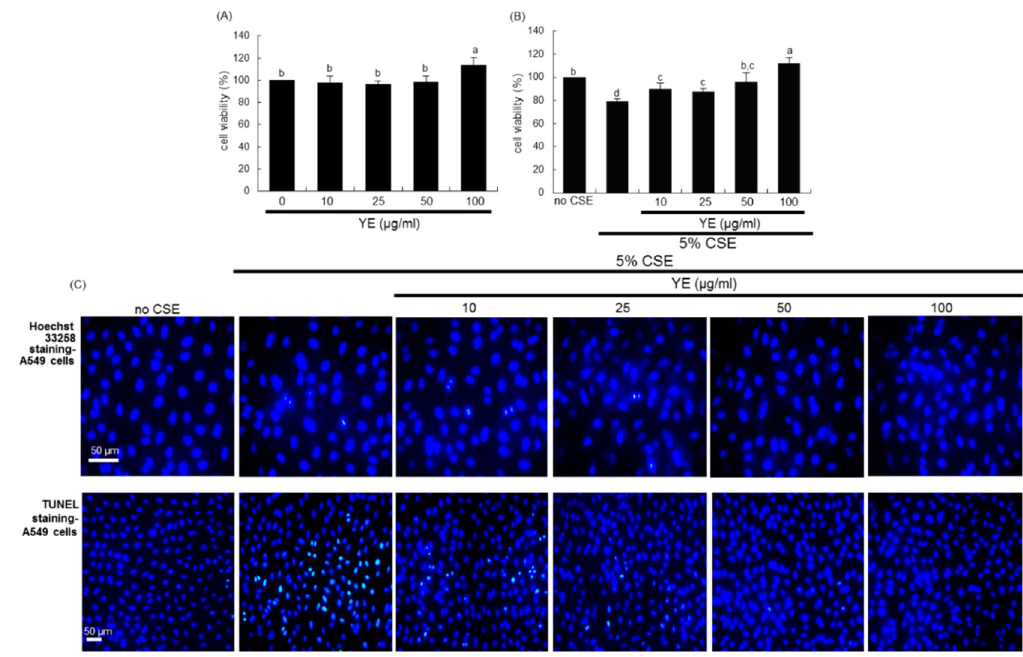
Figure 5. Viability of alveolar epithelial A549 cells and effects of dried yeast extracts (YE) on alveolar apoptosis. Alveolar epithelial cells were incubated in media containing 5% cigarette smoke extract (CSE) in the absence and presence of 10–100 µg/mL YE for up to 24 h. A549 cell viability (mean ± SEM, n = 5) was measured by using MTT assay and expressed as percent cell survival relative to untreated controls ( A and B ). Values in respective bar graphs not sharing a same small letter indicate a significant difference at p < 0.05. Nuclear staining was done with Hoechst 33258 dye for the detection of apoptotic cells ( C ). A transferase dUTP nick end labeling (TUNEL) assay was conducted to detect DNA fragmentation of apoptotic A549 cells and nuclear staining was accomplished with DAPI ( C ). Representative microphotographs were obtained by fluorescence microscopy. Scale bars = 50 µm.